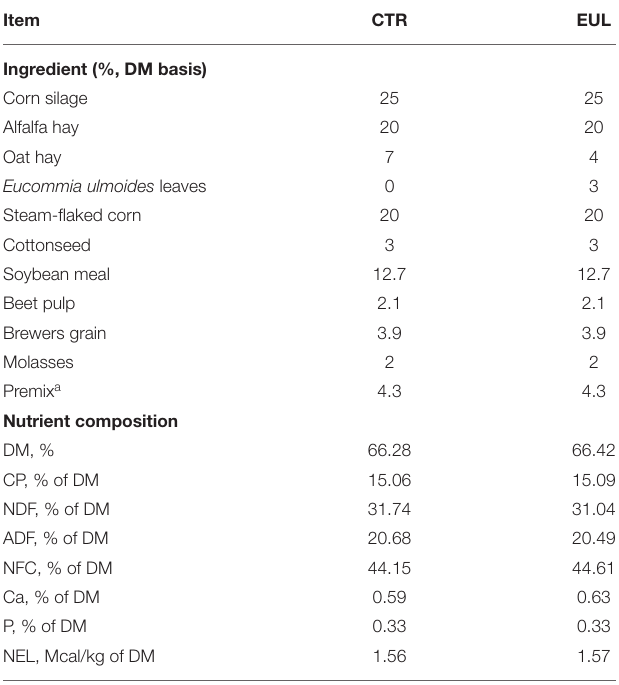
TABLE 1 | Experimental diet